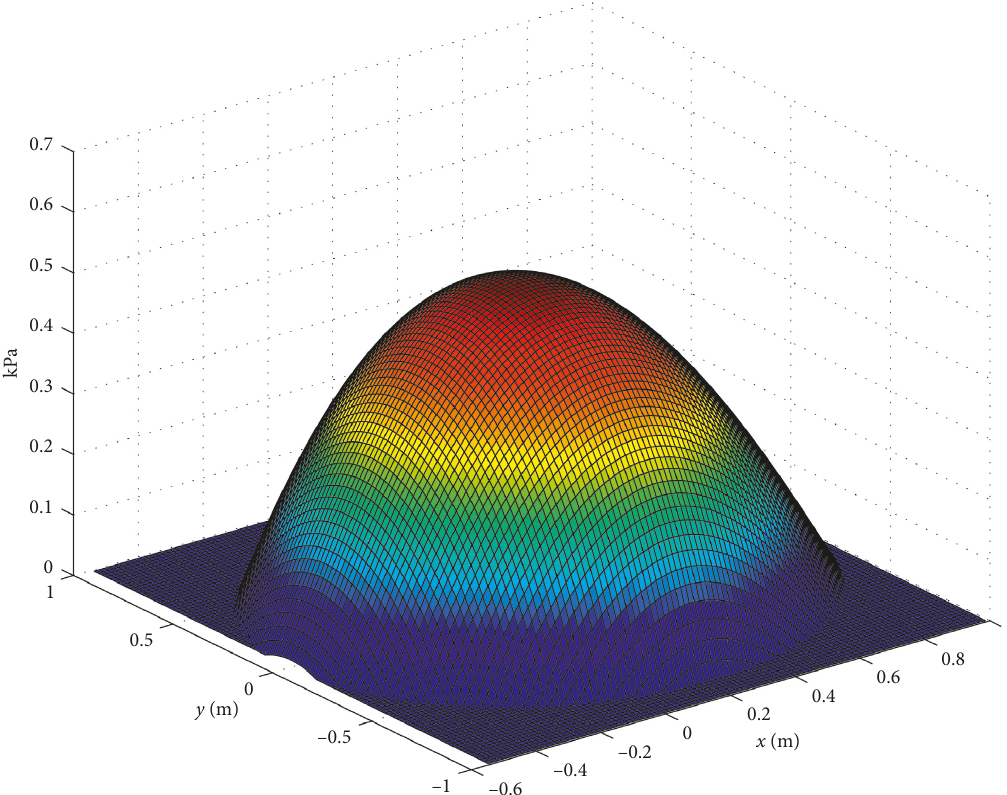
Figure 9: The distribution of normal stresses for case